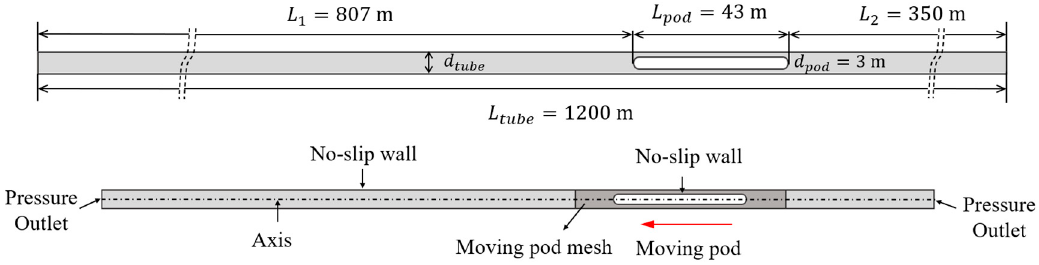
Figure 1. Geometry and boundary conditions of the simulation. 𝑑 (cid:3047)(cid:3048)(cid:3029)(cid:3032) = 5 m for BR = 0.36 and 𝑑 (cid:3047)(cid:3048)(cid:3029)(cid:3032) = 6 m for BR =